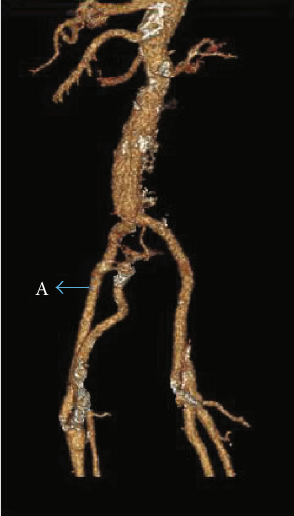
Figure 1: Showing graft (A) and stenosed, native femoral artery.